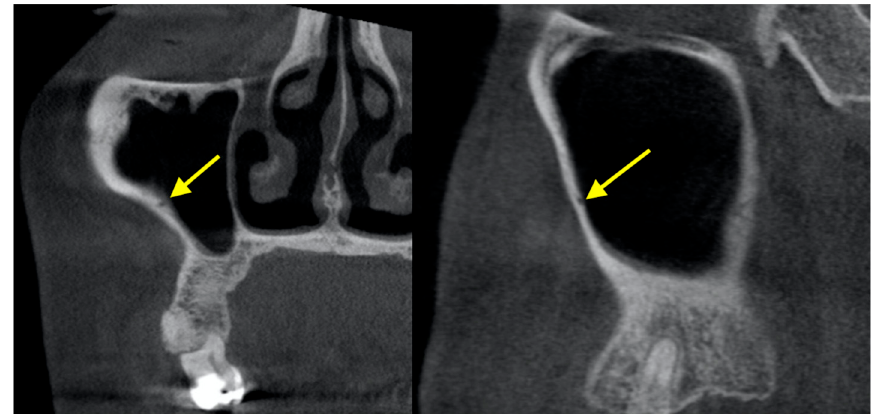
Figure 1. Posterior superior alveolar artery shown in